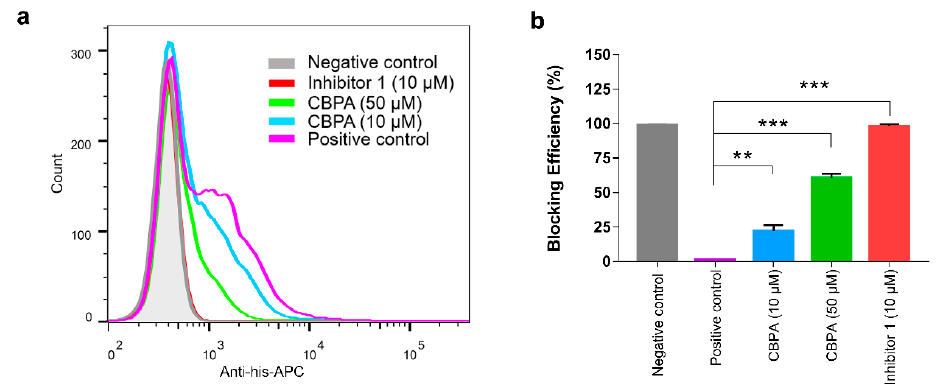
Figure 3. Inhibitory activity of CBPA based on flow cytometry assays. ( a ) Representative flow cytometry histogram for evaluating the efficacy of CBPA in disrupting hPD-L1–hPD-1 interaction. ( b ) Blocking efficiencies are displayed as means ± SEM from three separate experiments, ** p < 0.01, *** p < 0.001, unpaired t -test.